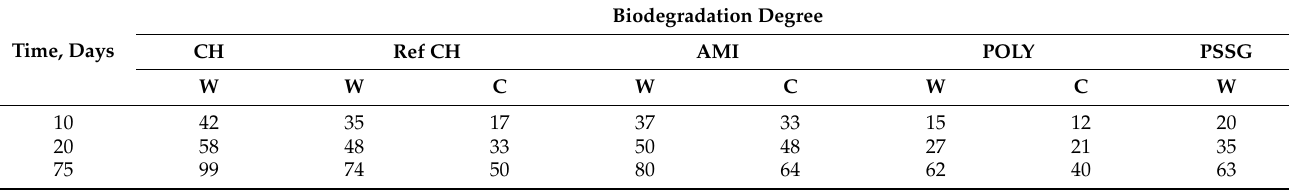
Table 3. Biodegradation degree evolution in time *